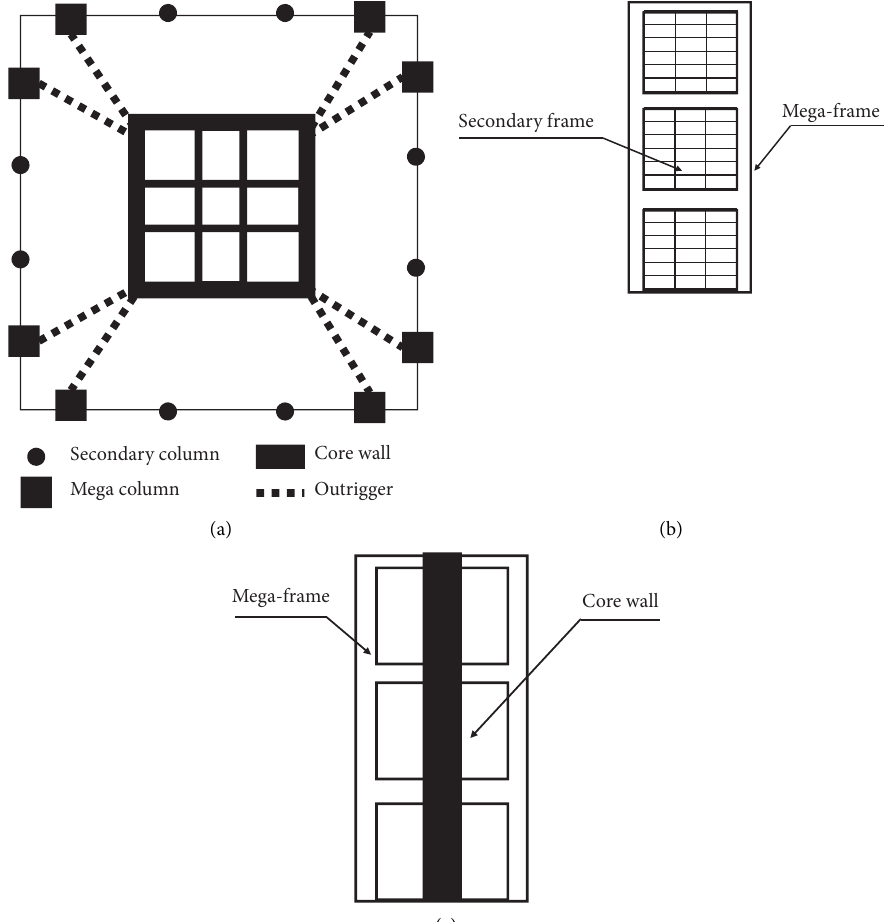
Figure 1: Schematic diagram of the mega-frame core wall structure system: (a) plan, (b) elevation, and (c)